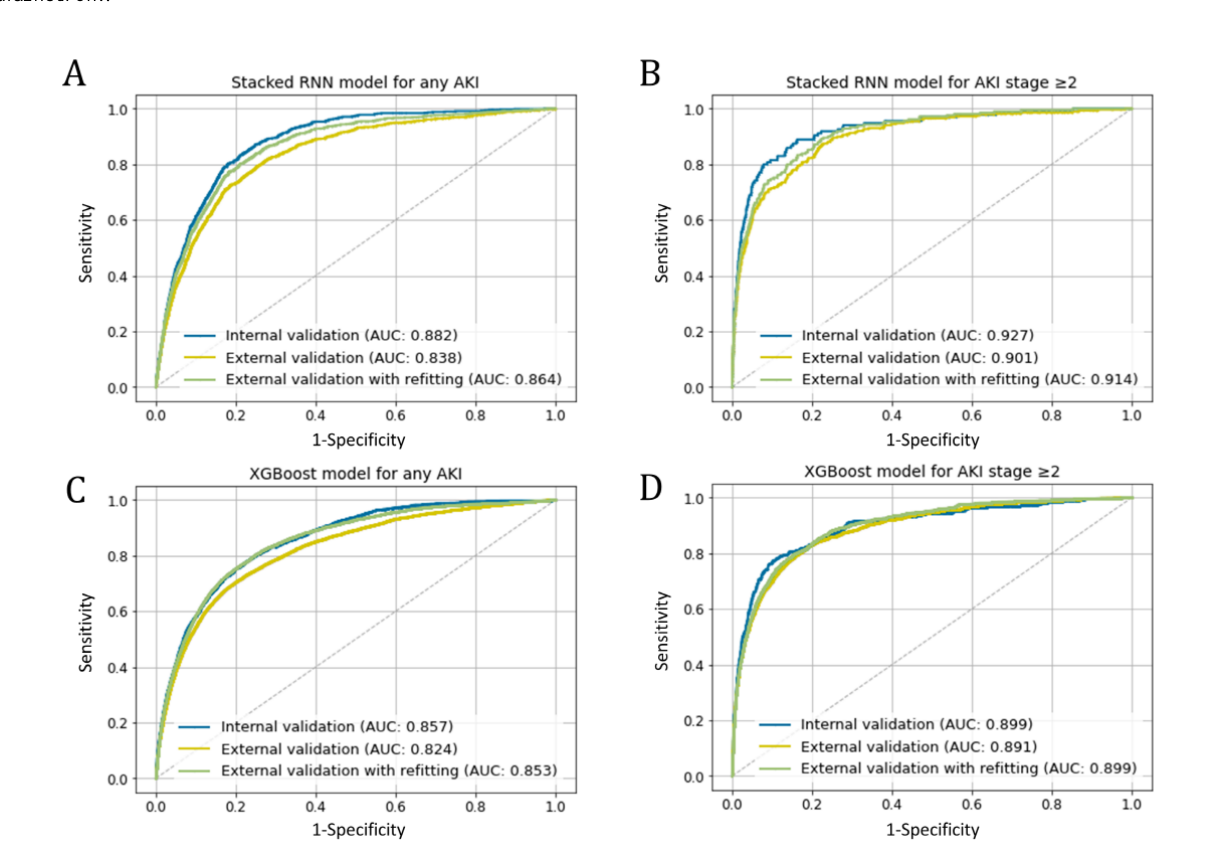
Figure 2. The receiver operating characteristic curve for model 1. (A) The stacked RNN model for any AKI, (B) the stacked RNN model for AKI stage 2 or higher, (C) the XGBoost model for any AKI, and (D) the XGBoost model for AKI stage 2 or higher. AKI: acute kidney injury; RNN: recurrent neural network.